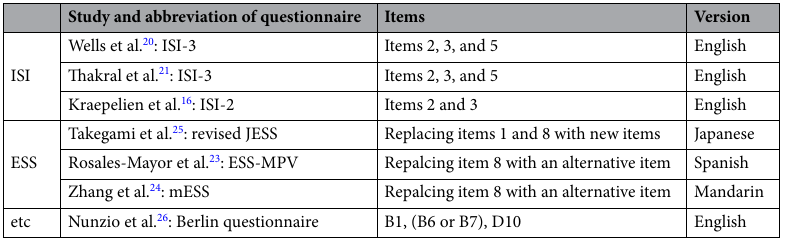
Table 3. Summary of previous researches about simplification of sleep questionnaire.